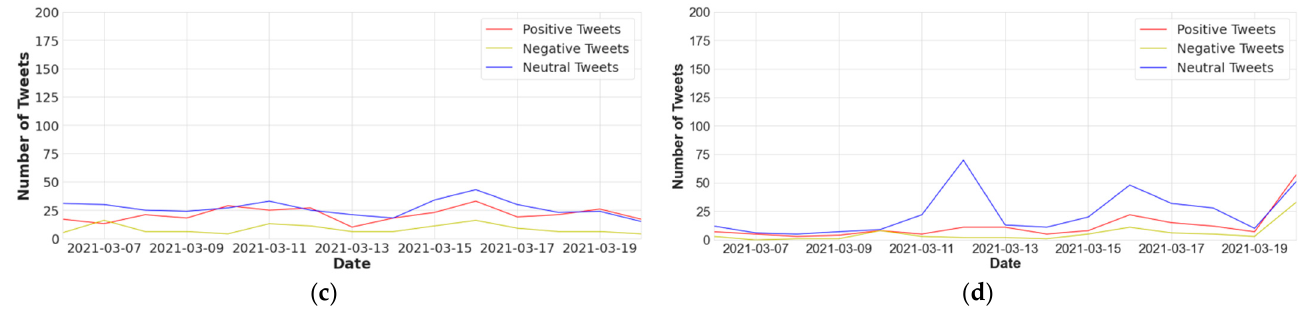
Figure 4. Distribution of four COVID-19 vaccines’ tweets across sentiment types: ( a ) distribution of Covaxin tweets across sentiment types; ( b ) distribution of Moderna tweets across sentiment types; ( c ) distribution of Pfizer tweets across sentiment types; ( d ) distribution of Sinopharm tweets across sentiment types.